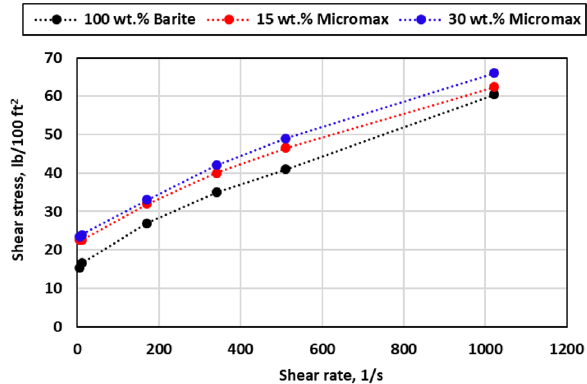
Fig. 6 Flow curves for the drilling fluid samples (350